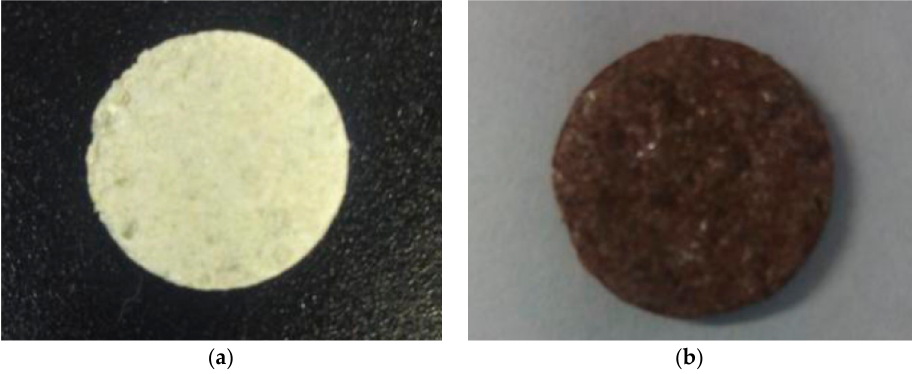
Figure 1. Example of discs made from powder mix for contract angle measure. ( a ) mica mixed with kaolinite; and ( b ) mica mixed with kaolinite and aged in crude oil.